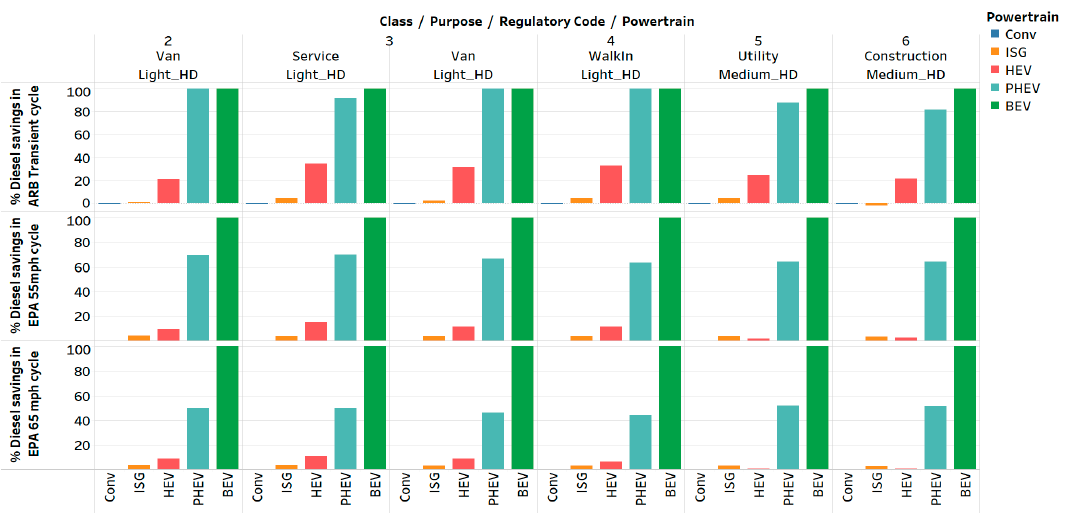
Figure 7. Fuel savings in medium-duty trucks.